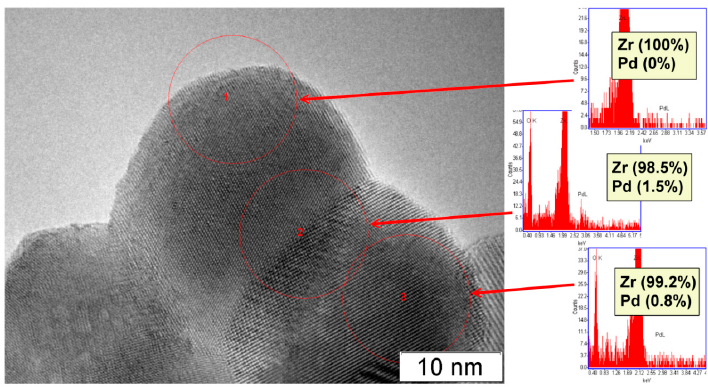
Figure 3. Pd concentration in different areas of 2% Pd/ZrO 2 sample. Transmission electron microscopy and energy-dispersive X-ray spectroscopy data.